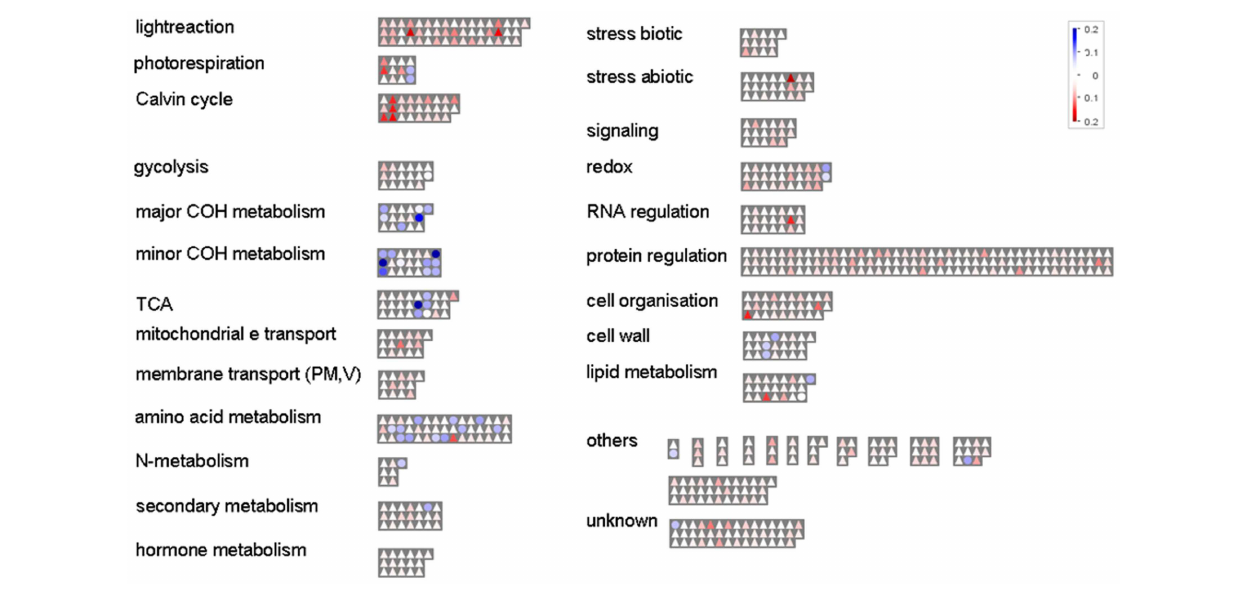
FIGURE 1 | Mapman overview. Functional distribution and relative abundance of the 643 shoot proteins (Log10 of the spectral count normalized by protein weight; FDR ≤ 0.01%) and 45 metabolites (Log10